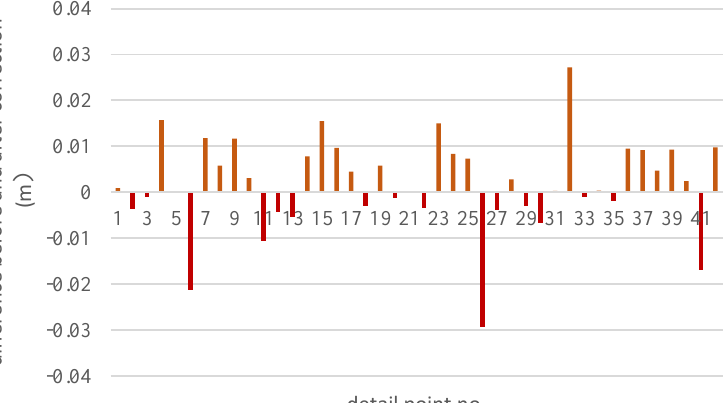
Figure 30. Error difference of digitized detail line data using the corrected and uncorrected handheld LiDAR point clouds.